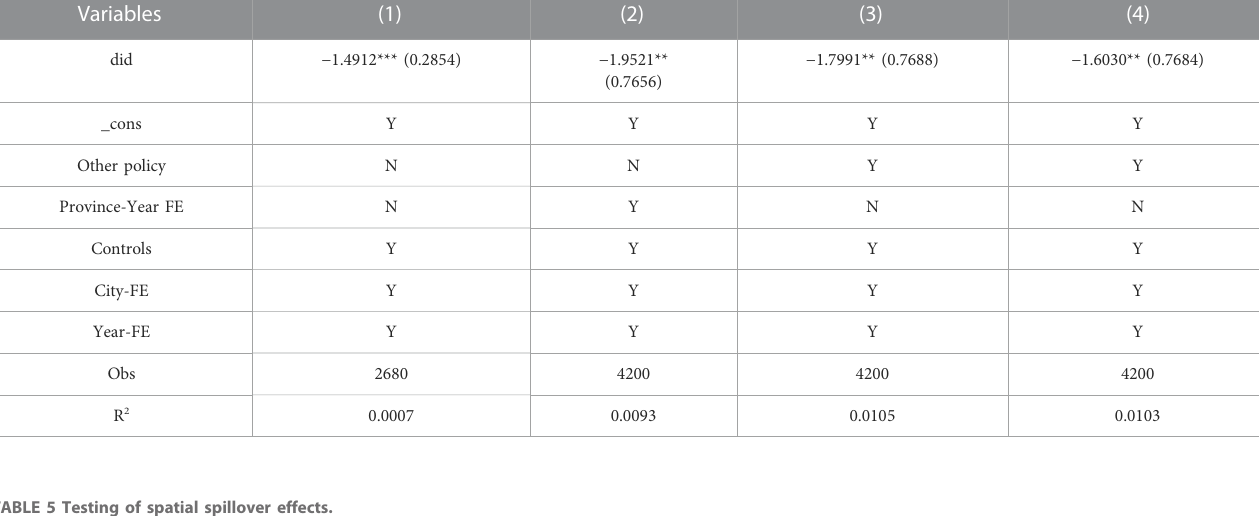
TABLE 5 Testing of spatial spillover effects.